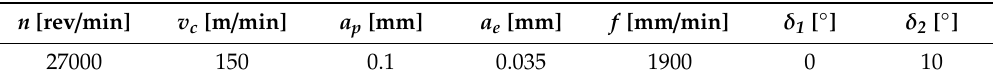
Table 3. Recommended cutting data values.